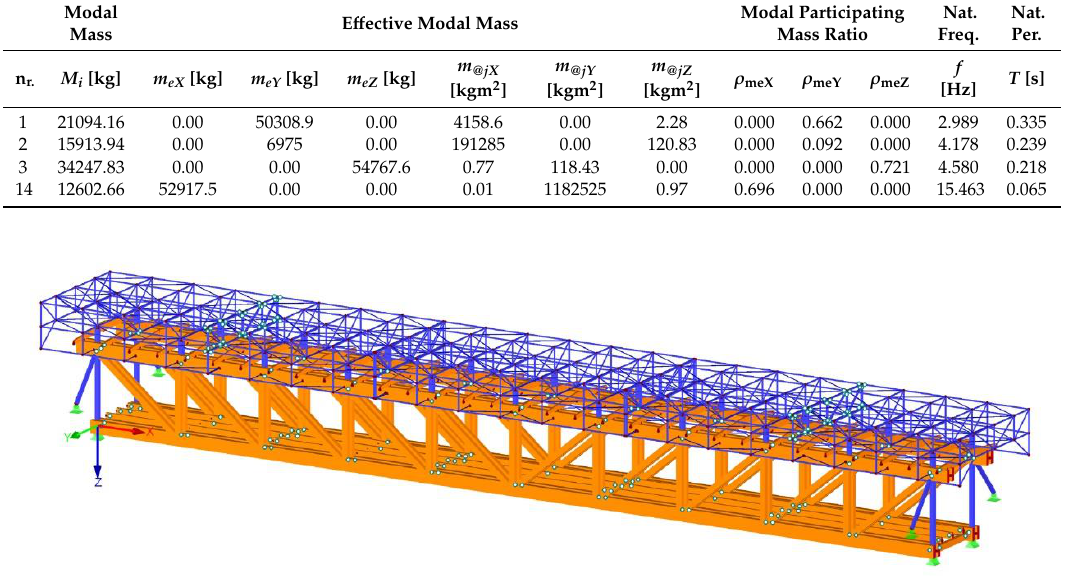
Figure 9. Three-dimensional model of the initial configuration.